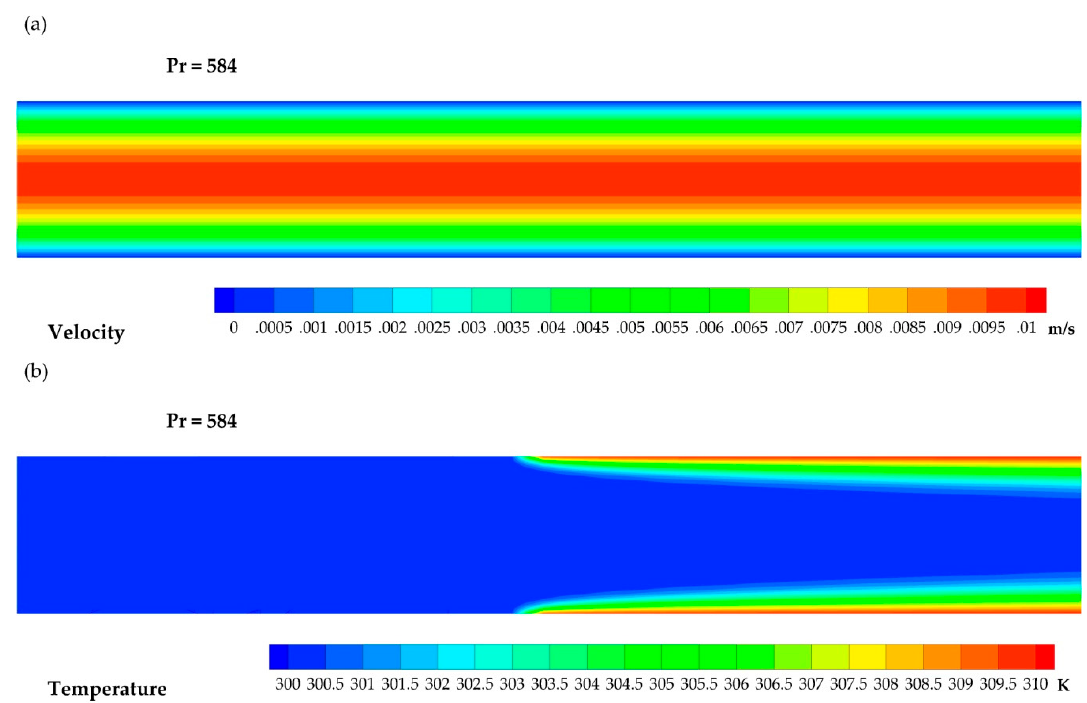
Figure 5. Flow without the influence of the magnetic field, Prandtl number equal to 584: ( a ) Velocity field; ( b ) temperature field.